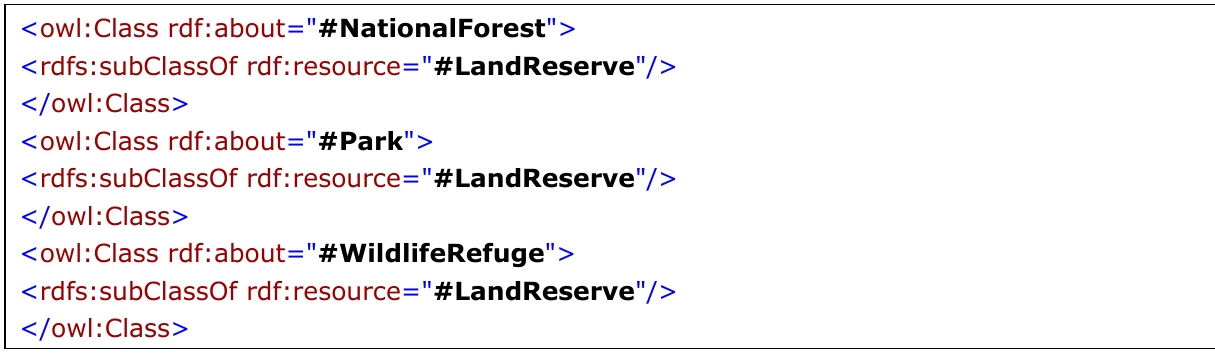
Figure 10. SWEET ontology LandReserve sub-classes.